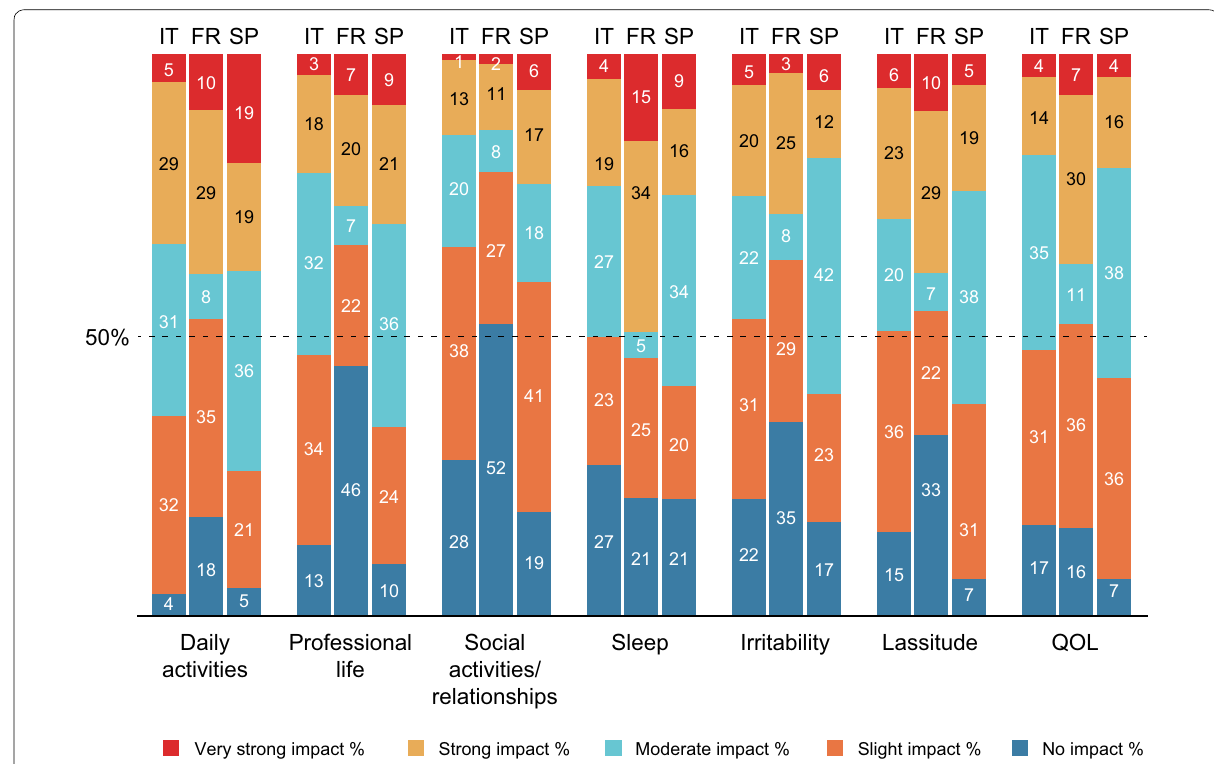
Fig. 2 Impact of symptoms on seven types of life activity at baseline (as self-reported by participants in the post-inclusion